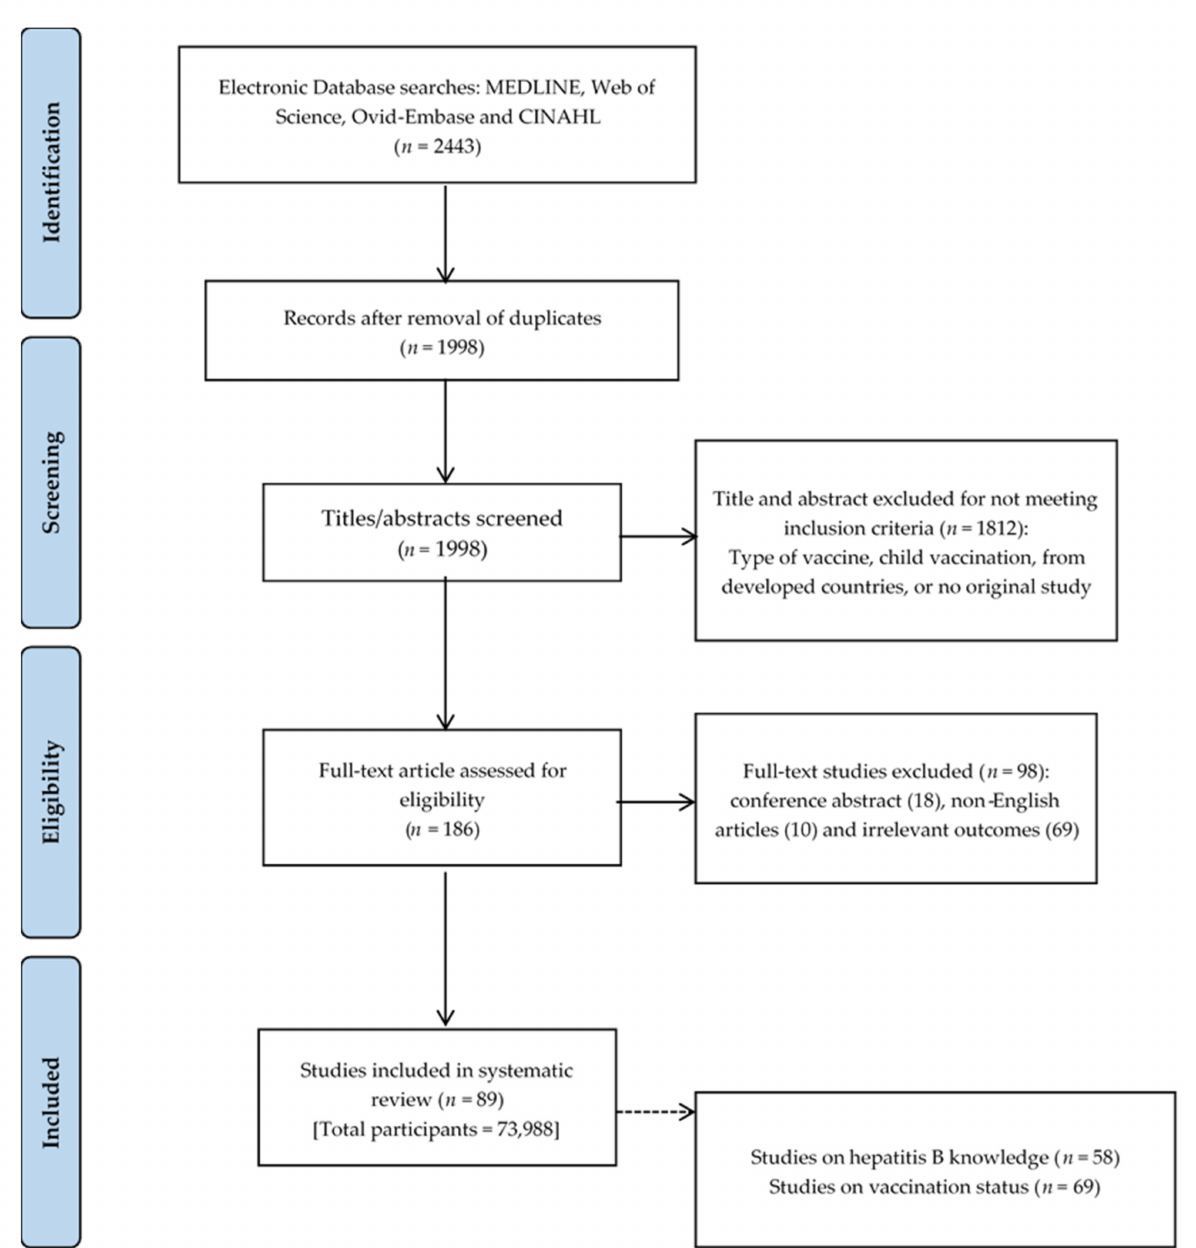
Figure 1. Flowchart of study search (adopted PRISMA: